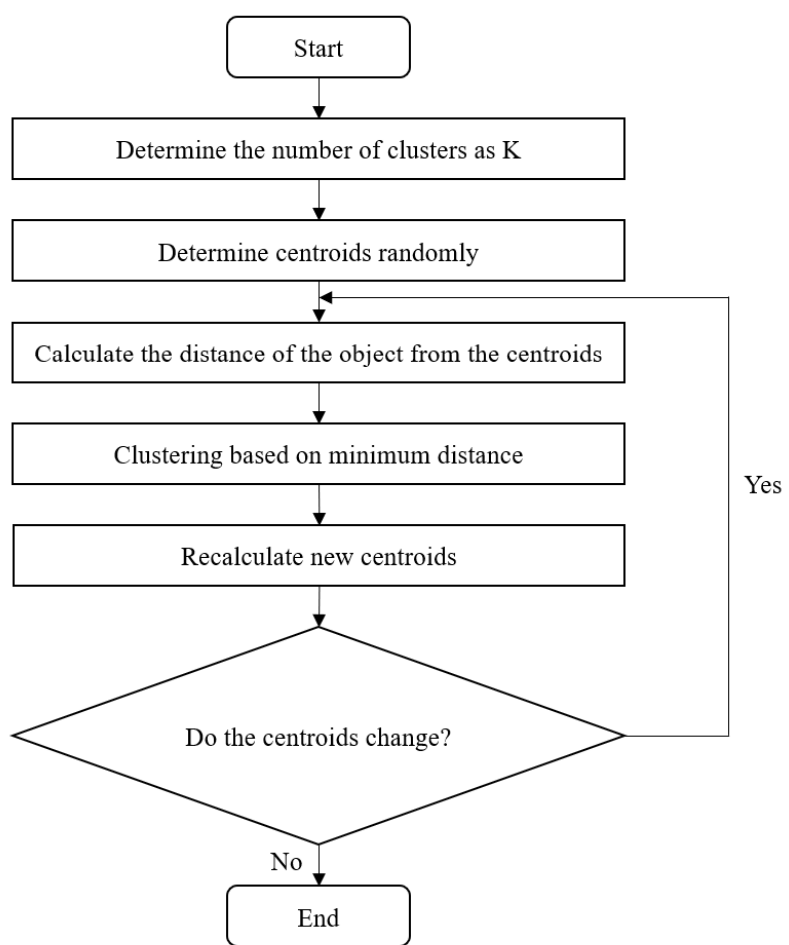
Figure 4. Flowchart of the K-means clustering algorithm.